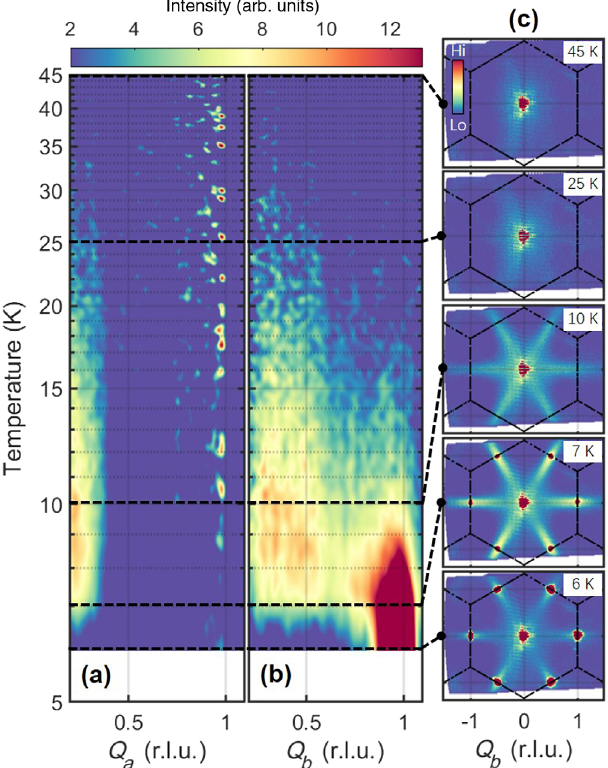
FIG. 5. (a),(b) Variable- T diffuse magnetic scattering in zero field, viewed along Q and Q starting from near the Γ point, a b after subtracting the T ¼ 45 K data as background. (c) Scattering in the 2D Brillouin zone at selected temperatures. Unlike the nuclear ( Γ -point) and magnetic ( M -point) Bragg peaks, the diffuse scattering does not show noticeable Q ⊥ dependence, and the displayed data are Q ⊥ integrated and restricted to a small energy window of (cid:4) 0 . 2